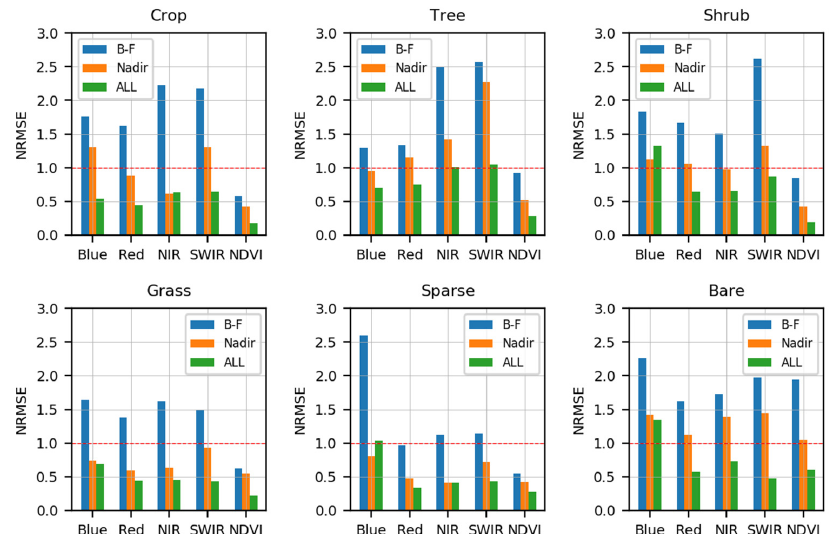
Figure 17. The figure shows the NRMSE of the estimated drifts for the different angular conditions: blue bars are the azimuthal symmetry (difference in the drifts estimated for backward and forward scattering), orange bars are near nadir observations (VZA < 10°) and green bars correspond to all observations. The NRMSE is computed for each per land cover class and spectral bands, including NDVI. The red horizontal line is the threshold value used to identify a statistically significant impact of the orbital drift in the TOC archive.